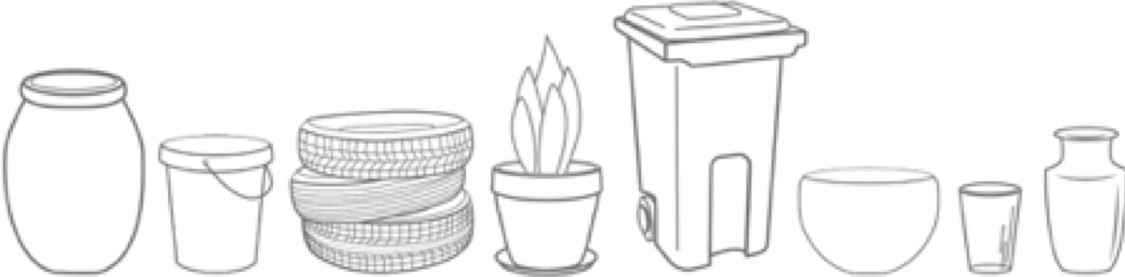
Fig 3. Eight outdoor container types detected from street view images [4], from left to right: Jar, bucket, discarded tire, potted plant, bin, bowl, miscellaneous short open, miscellaneous tall open.